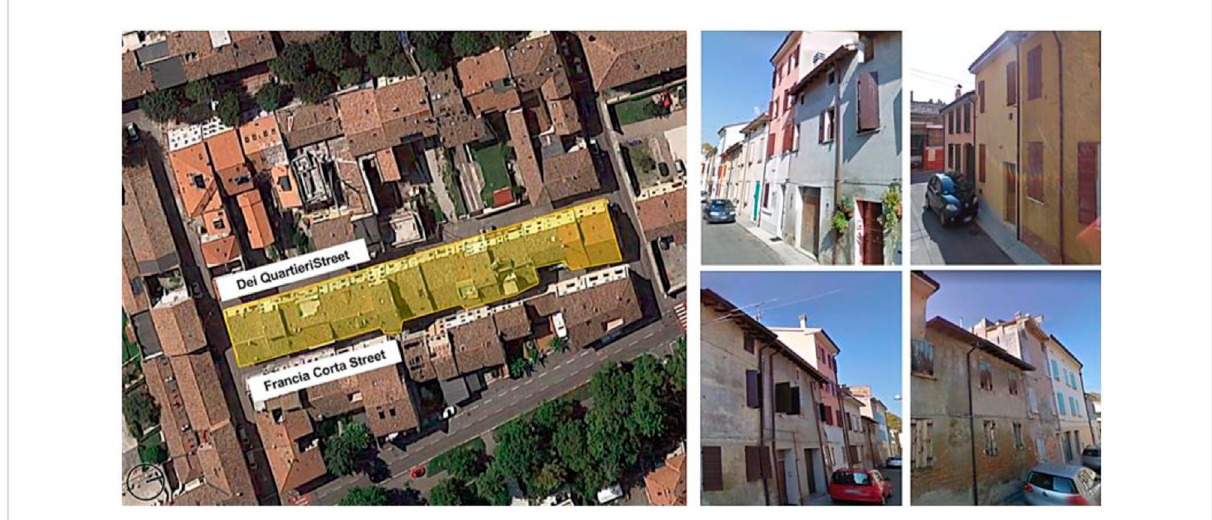
Frontiers in Built